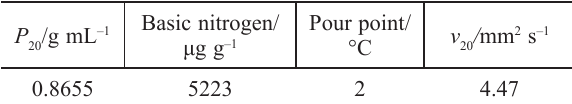
Table 1 – Properties of diesel fraction from Fushun shale oil